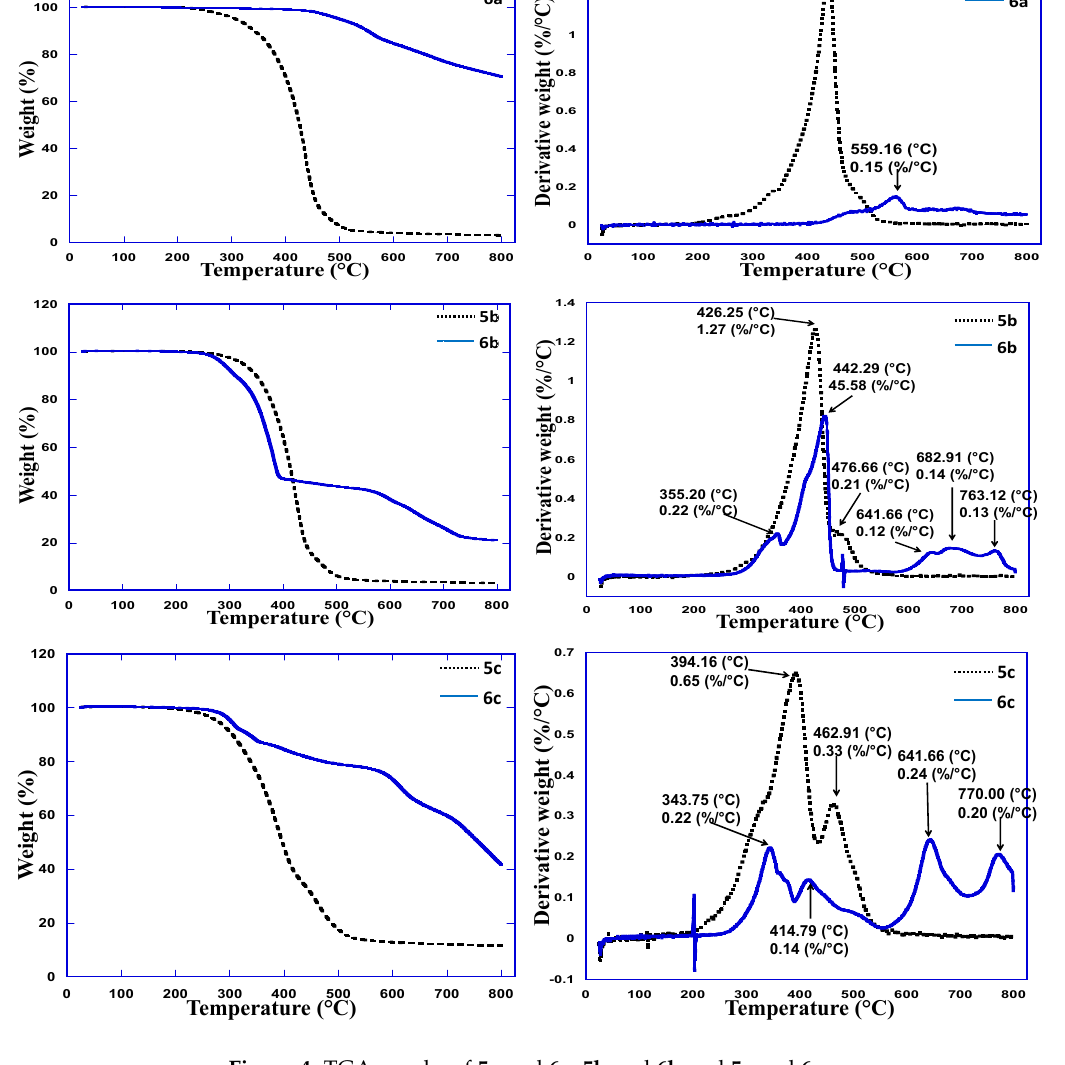
Figure 4. TGA graphs of 5a and 6a , 5b and 6b and 5c and 6c .